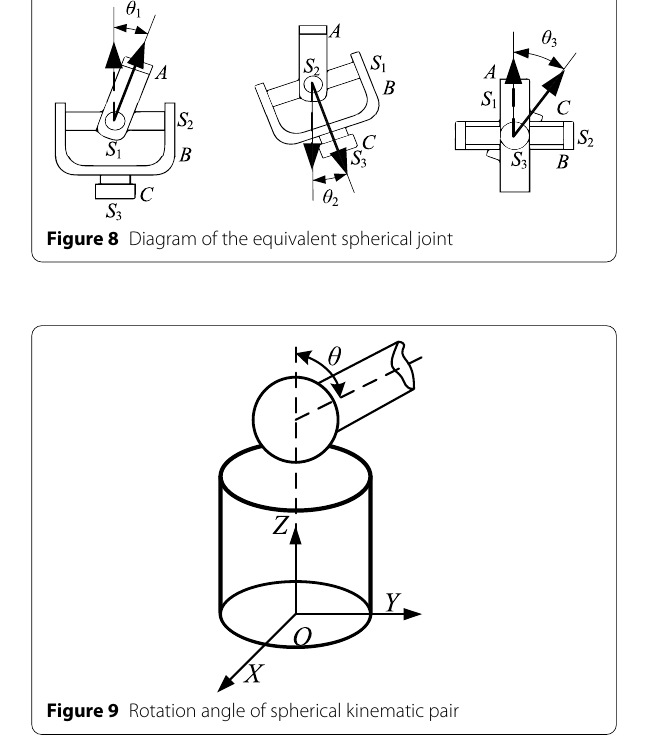
For the convenience of calculation, the three rotation angles of the equivalent spherical joint are simplified as the rotation angle θ of the spherical joint, which is shown in Figure 9. The rotation angle θ of the spherical pair is deter- mined by the Z axis of the moving coordinate system and the vector u of the link, and its limitation value is the mini- mum value of θ i max . Similarly, the rotation angles of Hooke joint also have a range.